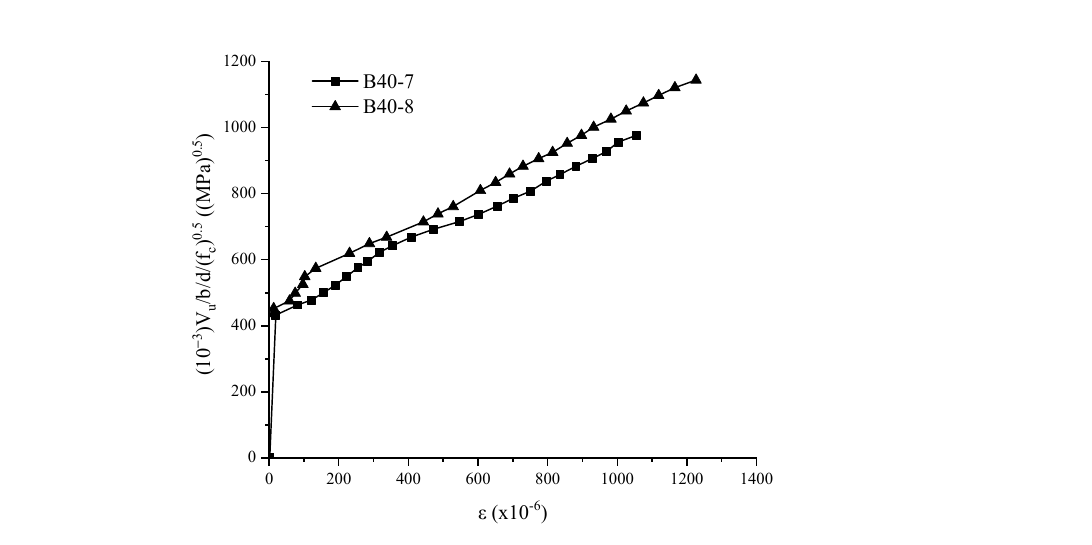
Figure 16. Relationship between normalized ultimate shear capacity V u and stirrup strain. Table 4. Experimental and calculated results of all beam